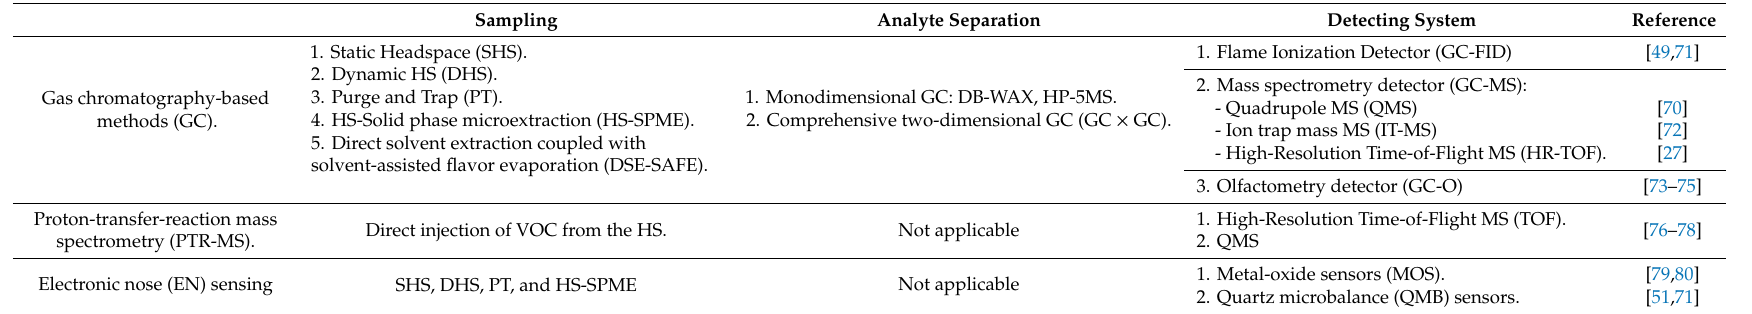
Table 2. Major analytical methods used for the determination of aroma compounds in tru ffl